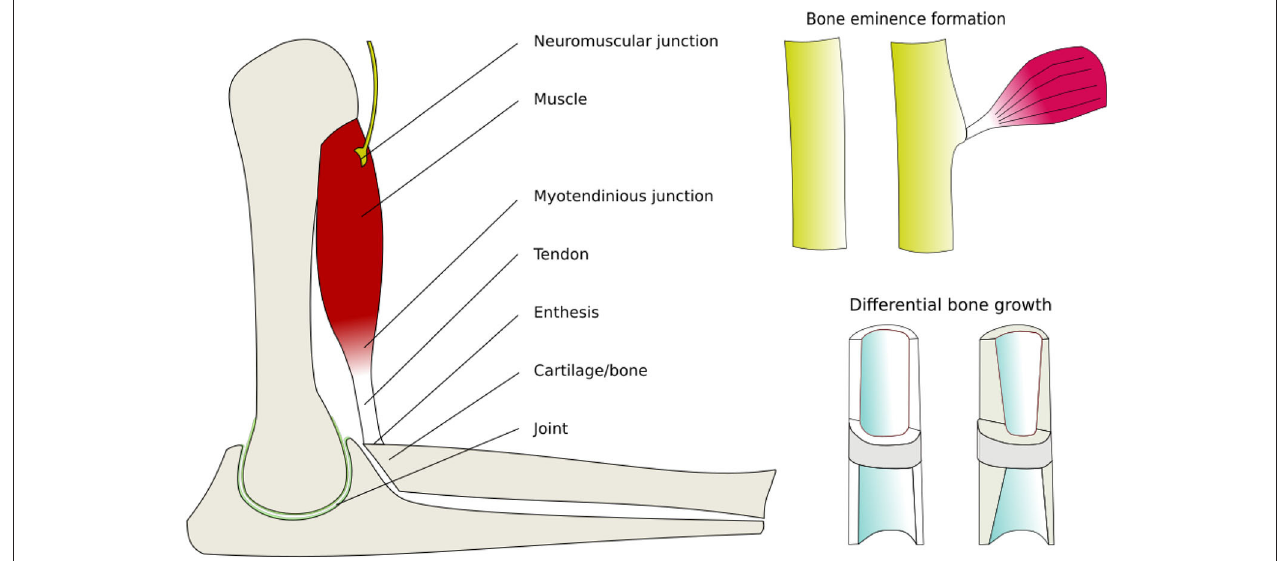
FIGURE 4 | Active mechanical regulation of musculoskeletal development. Drawn from data in Felsenthal and Zelzer (2017). Components of the musculoskeletal system that are actively remodeled by cells in response to mechanical forces, thereby producing balanced strength and